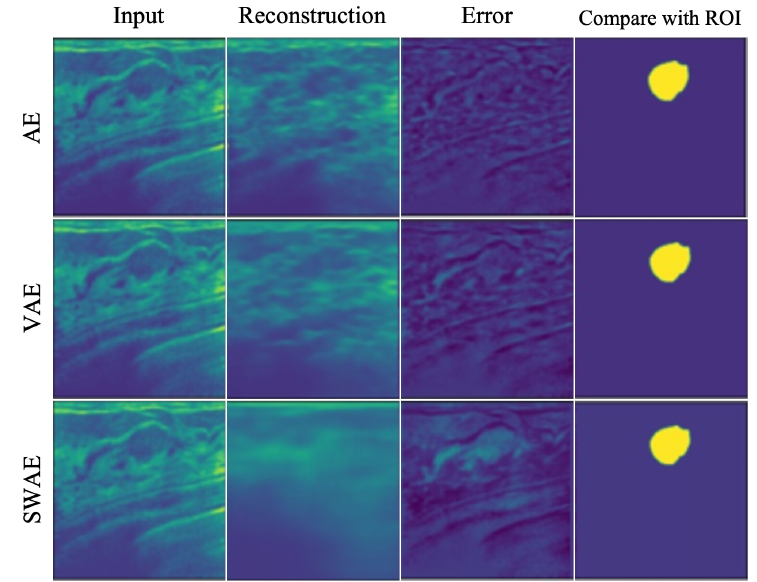
Figure 12. Anomalous region detection results with respect to threshold with applying Relu function.